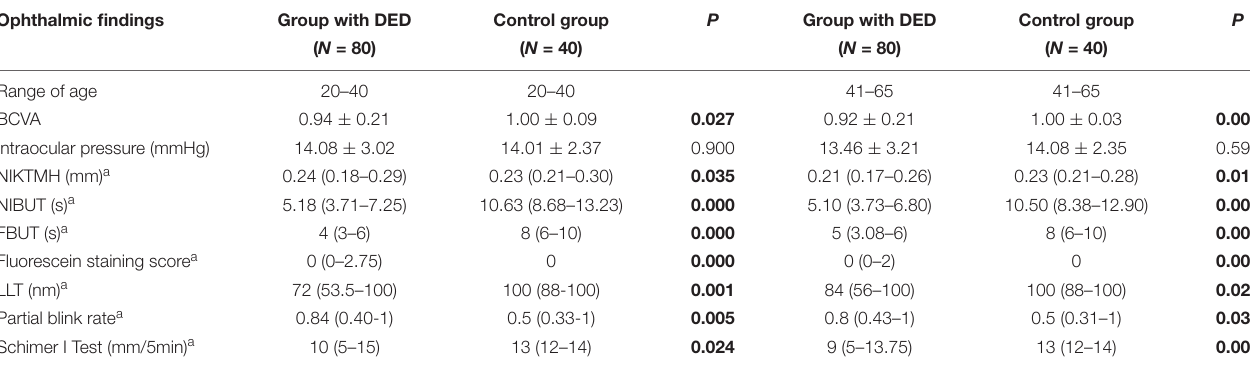
TABLE 2 | Ophthalmic findings in dry eye disease (DED) and control